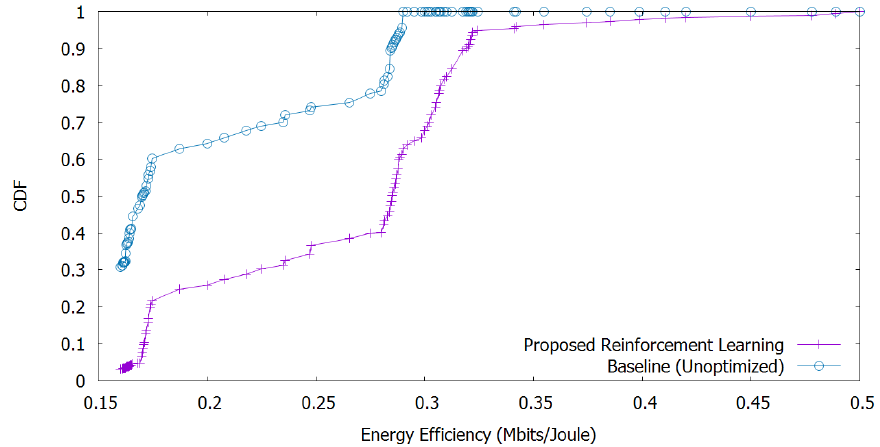
Figure 7. Cumulative distribution function (CDF) of energy efficiency of the connected UEs.